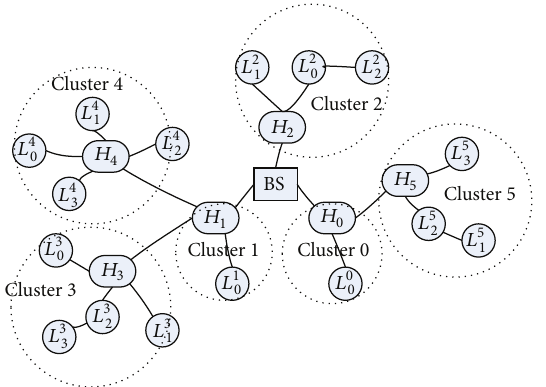
Figure 1: An example of a heterogeneous clustered-based WSN.